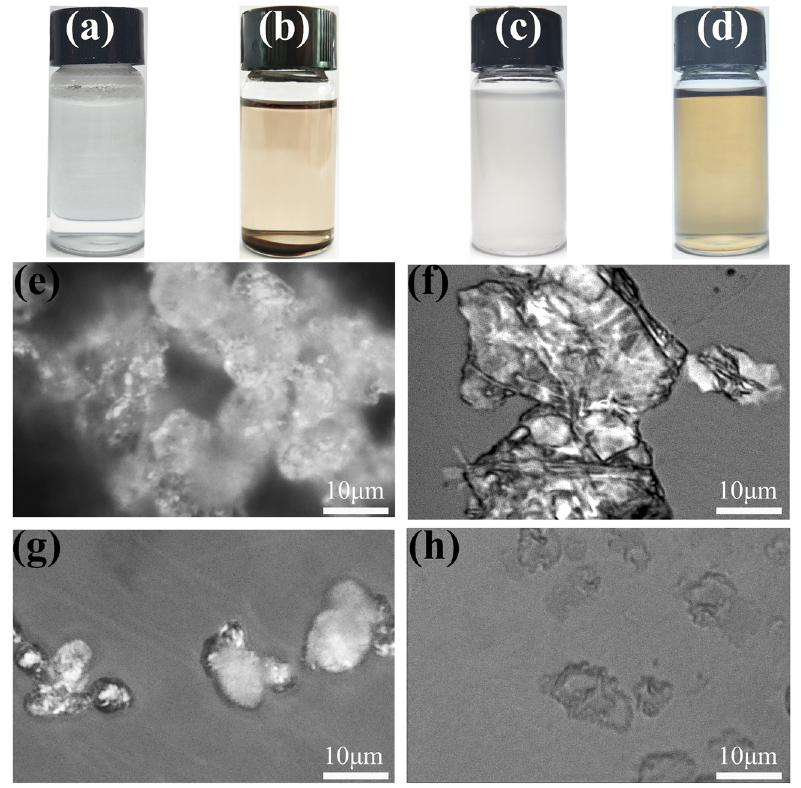
Figure 2: ( a ) Digital photographs of PEEK - NH 2 in H 2 O, ( b ) GO in DMF, ( c ) PEEK - NH 2 in DMF/H 2 O, and ( d ) GO in DMF/H 2 O, and ( e ) metallographic micrographs of PEEK - NH